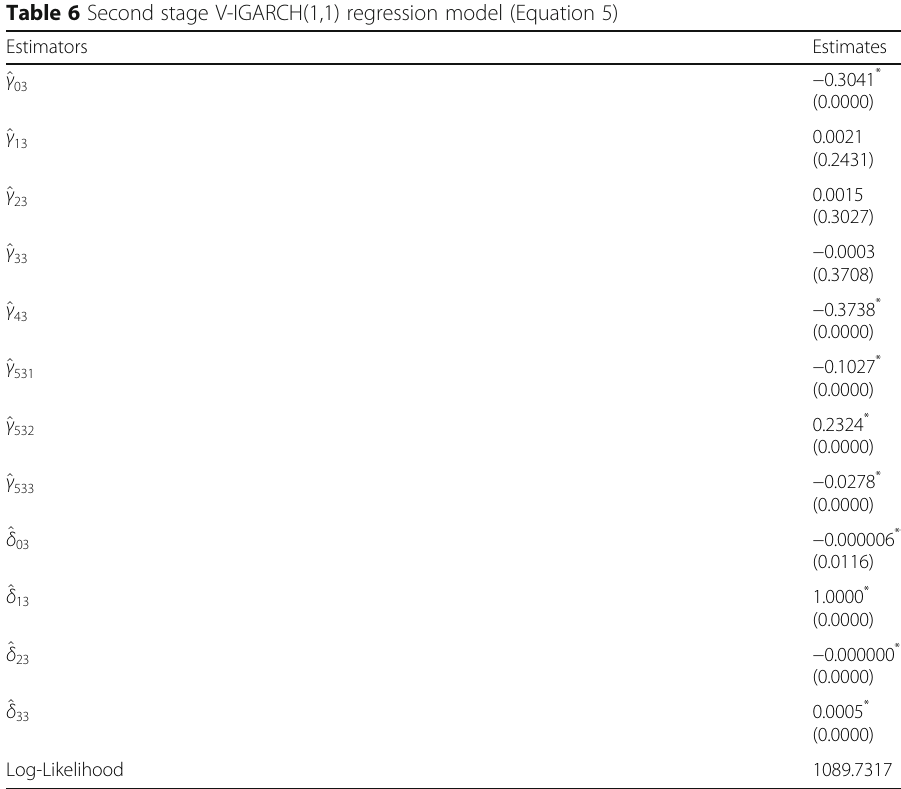
Table 6 Second stage V-IGARCH(1,1) regression model (Equation 5) Estimators